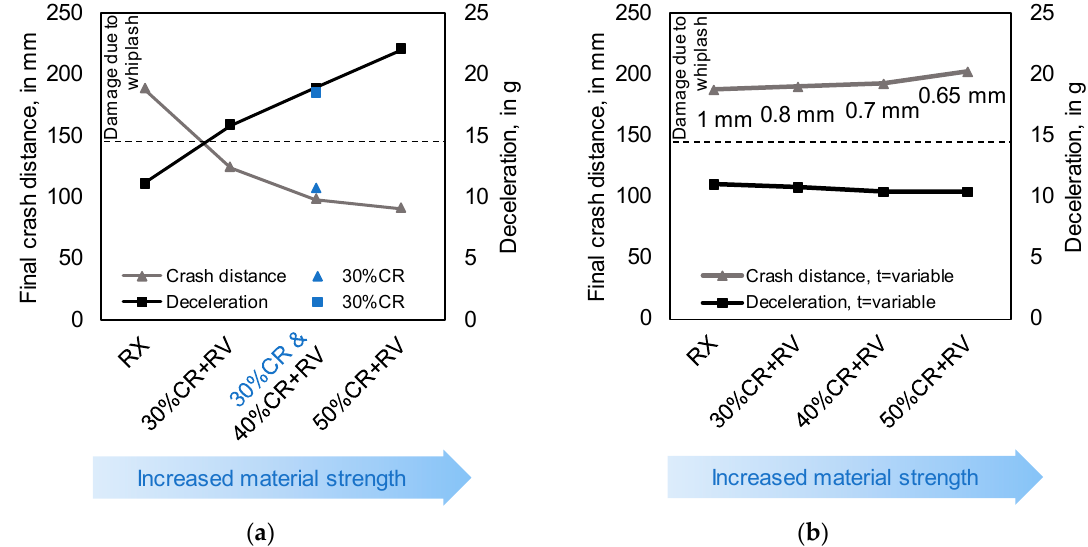
Figure 7. ( a ) Final crash distance and mean deceleration from FE parameter study for t = 1 mm for all material conditions; ( b ) Final crash distance and mean deceleration from FE parameter study for individual t for each material condition.